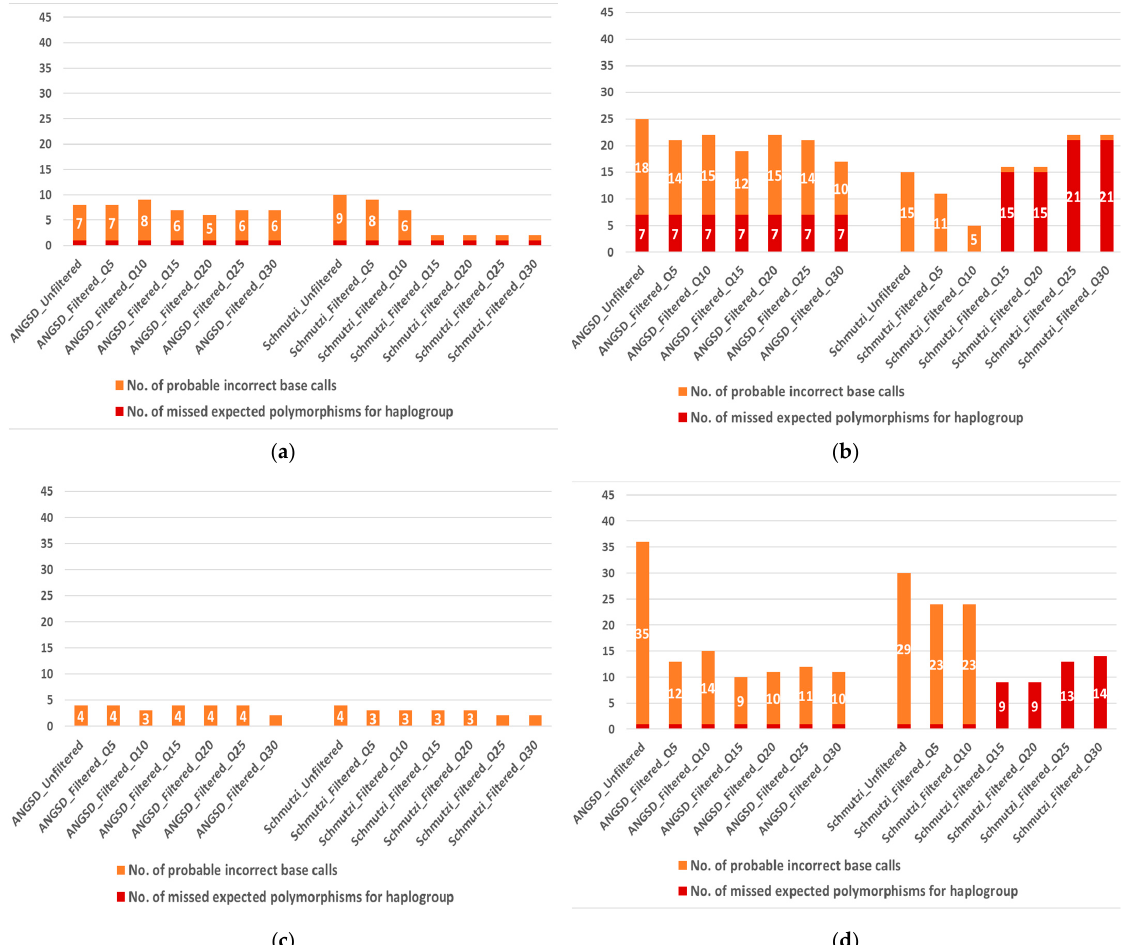
Figure 3. Possible errors in mitochondrial consensus sequence calling for analyzed samples as indicated during haplogroup prediction, presented by base-quality filter, by two alternative tools, and pipelines (ANGSD vs. schmutzi). Selected samples shown (display of all samples in Figure S2): ( a ) ZBC [29] is a moderate-coverage sample, in which quality filtering had a slightly differential effect on sequence calling errors, as applied by the two alternative tools; ( b ) ZMOJ [29] is a low-coverage sample, in which quality filtering had a clear differential effect on sequence calling errors, as applied by the two alternative tools; ( c ) ZHJ [29] is a low-coverage sample, in which quality filtering did not have any substantial effect on sequence calling errors; ( d ) KRD003 [30] is a very low-coverage sam-